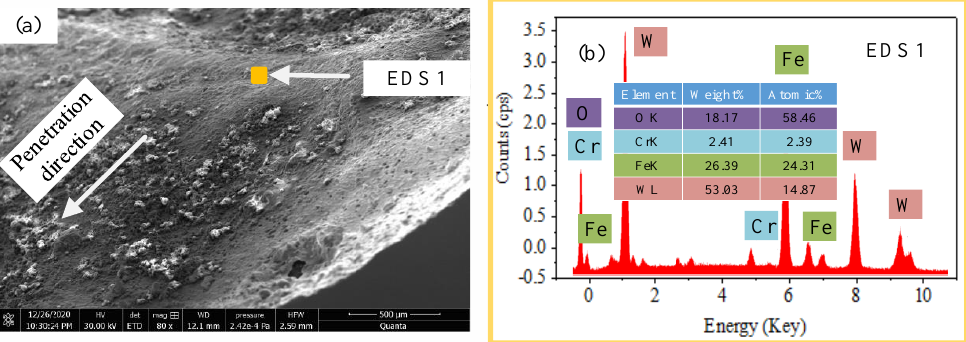
Figure 7. Internal surface morphology and EDS spectra of the crater. ( a ) Region I of the 93W crater and ( b ) EDS 1.